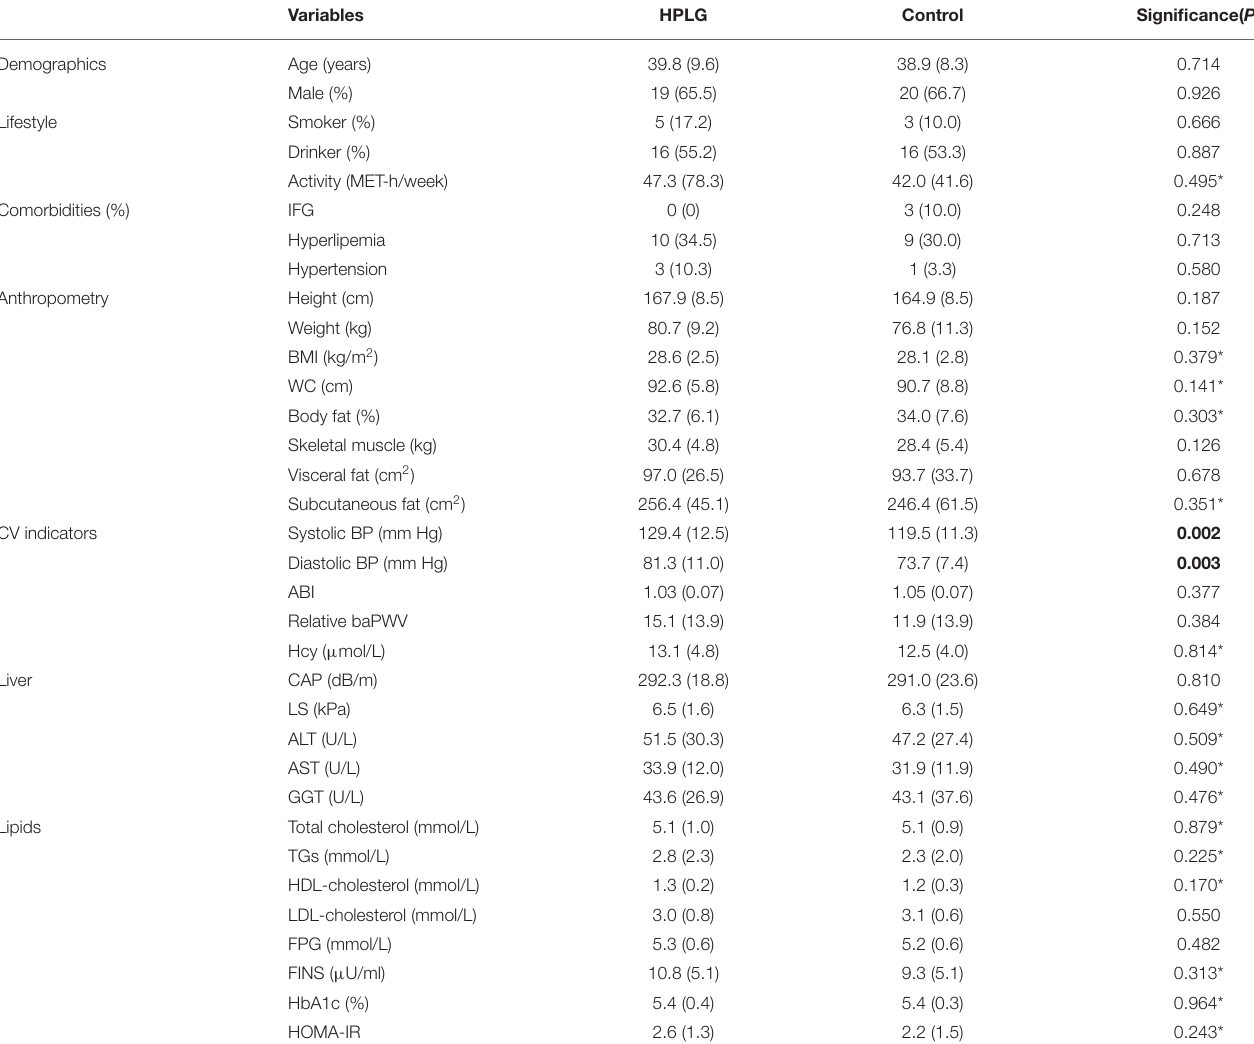
TABLE 1 | Baseline demographics and characteristics of the study